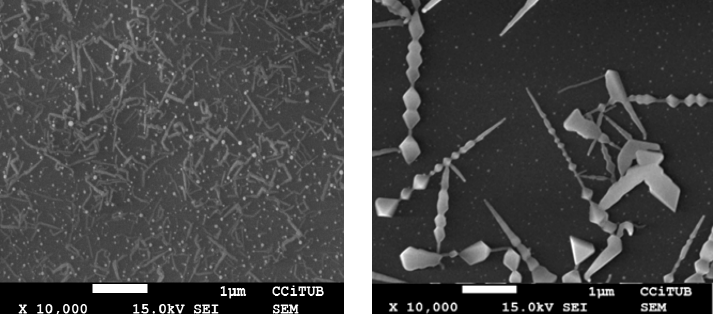
Figure 1. SEM images of the selected samples growed at 950